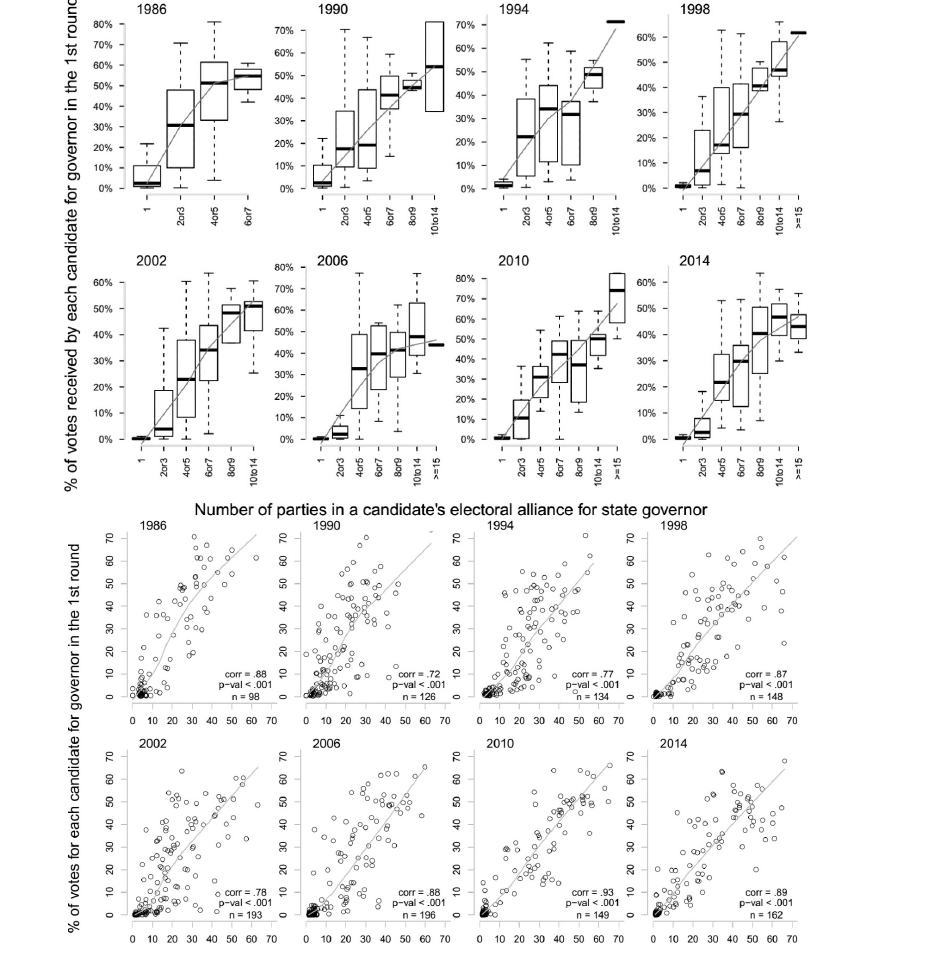
Graph 8. Votes obtained in the 1st round and size of electoral alliance for governor and Votes obtained in the 1st round and HGPE in elections for governor,